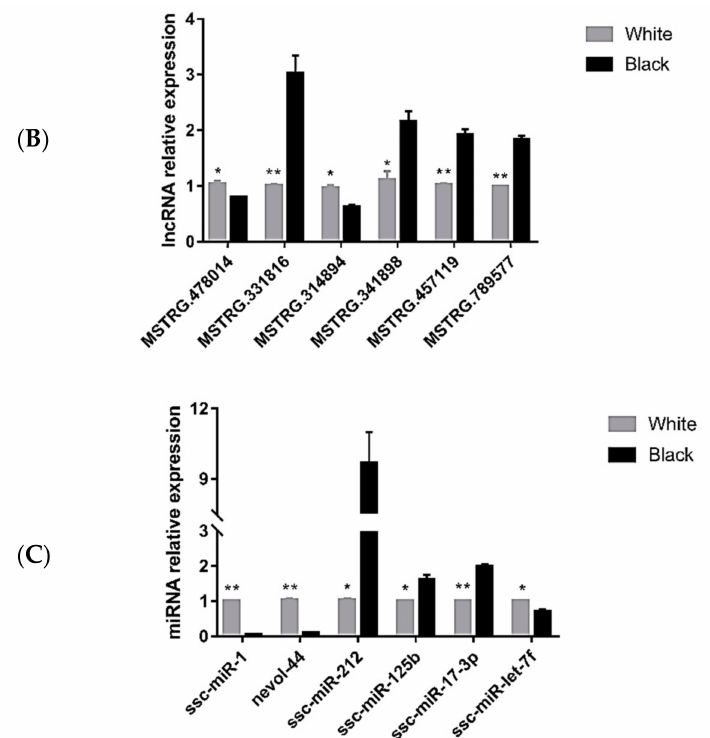
Figure 6. Quantitative PCR validation. Differentially expressed genes ( A ), lncRNAs ( B ) and miRNAs ( C ) were confirmed by quantitative PCR. Results are shown as means ± standard deviation of triplicate measurements. * indicates p < 0.05, ** indicates p <